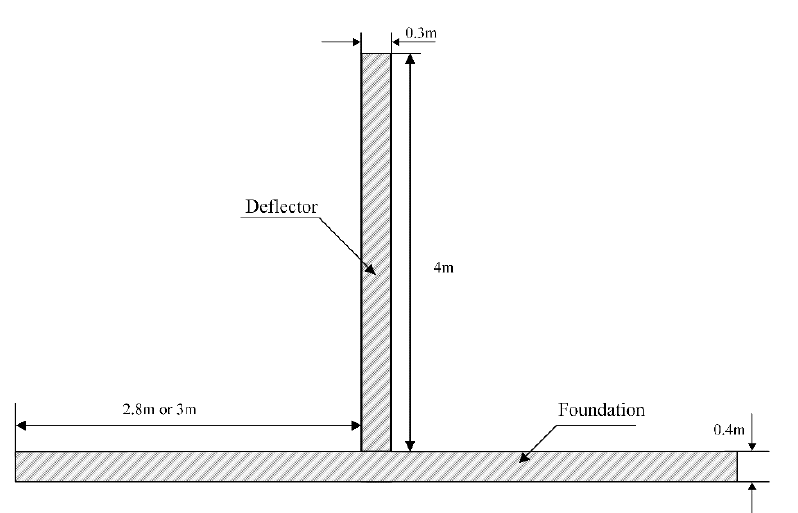
Figure 20. The sectional view of the foundation and the deflector.